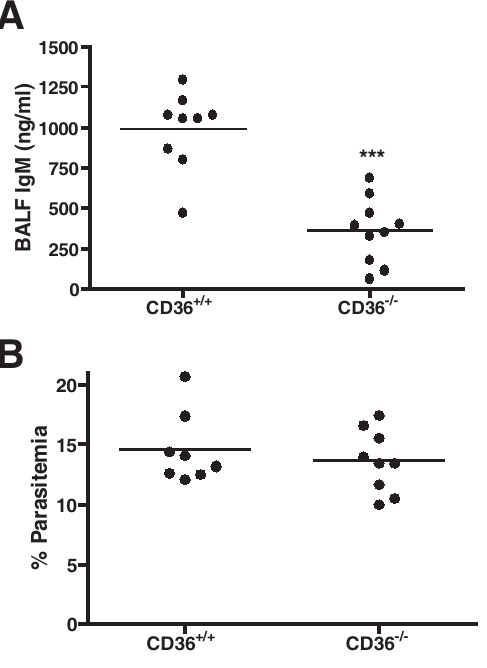
Figure 7. Cd36 2 / 2 mice develop significantly less ALI than wild- type mice. Previous studies have demonstrated that P. berghei binds in a CD36-dependent manner and sequesters preferentially in the lungs of infected mice. Hypothetically, mice with reduced lung parasite burden would be protected from the development of ALI. A. Infected Cd36 2 / 2 mice showed decreased BALF IgM concentration at Day 7 post infection compared to wildtype controls (2-tailed t-test, ***p , 0.0001); however, B. Cd36 + / + and Cd36 2 / 2 mice developed equivalent peripheral parasit- emias and died from CM during the same time frame (data not shown). Nine CD36 2 / 2 mice and 10 Cd36 + / + mice were used per group, and the data are representative of two independent experiments. Therefore, ALI in this model is